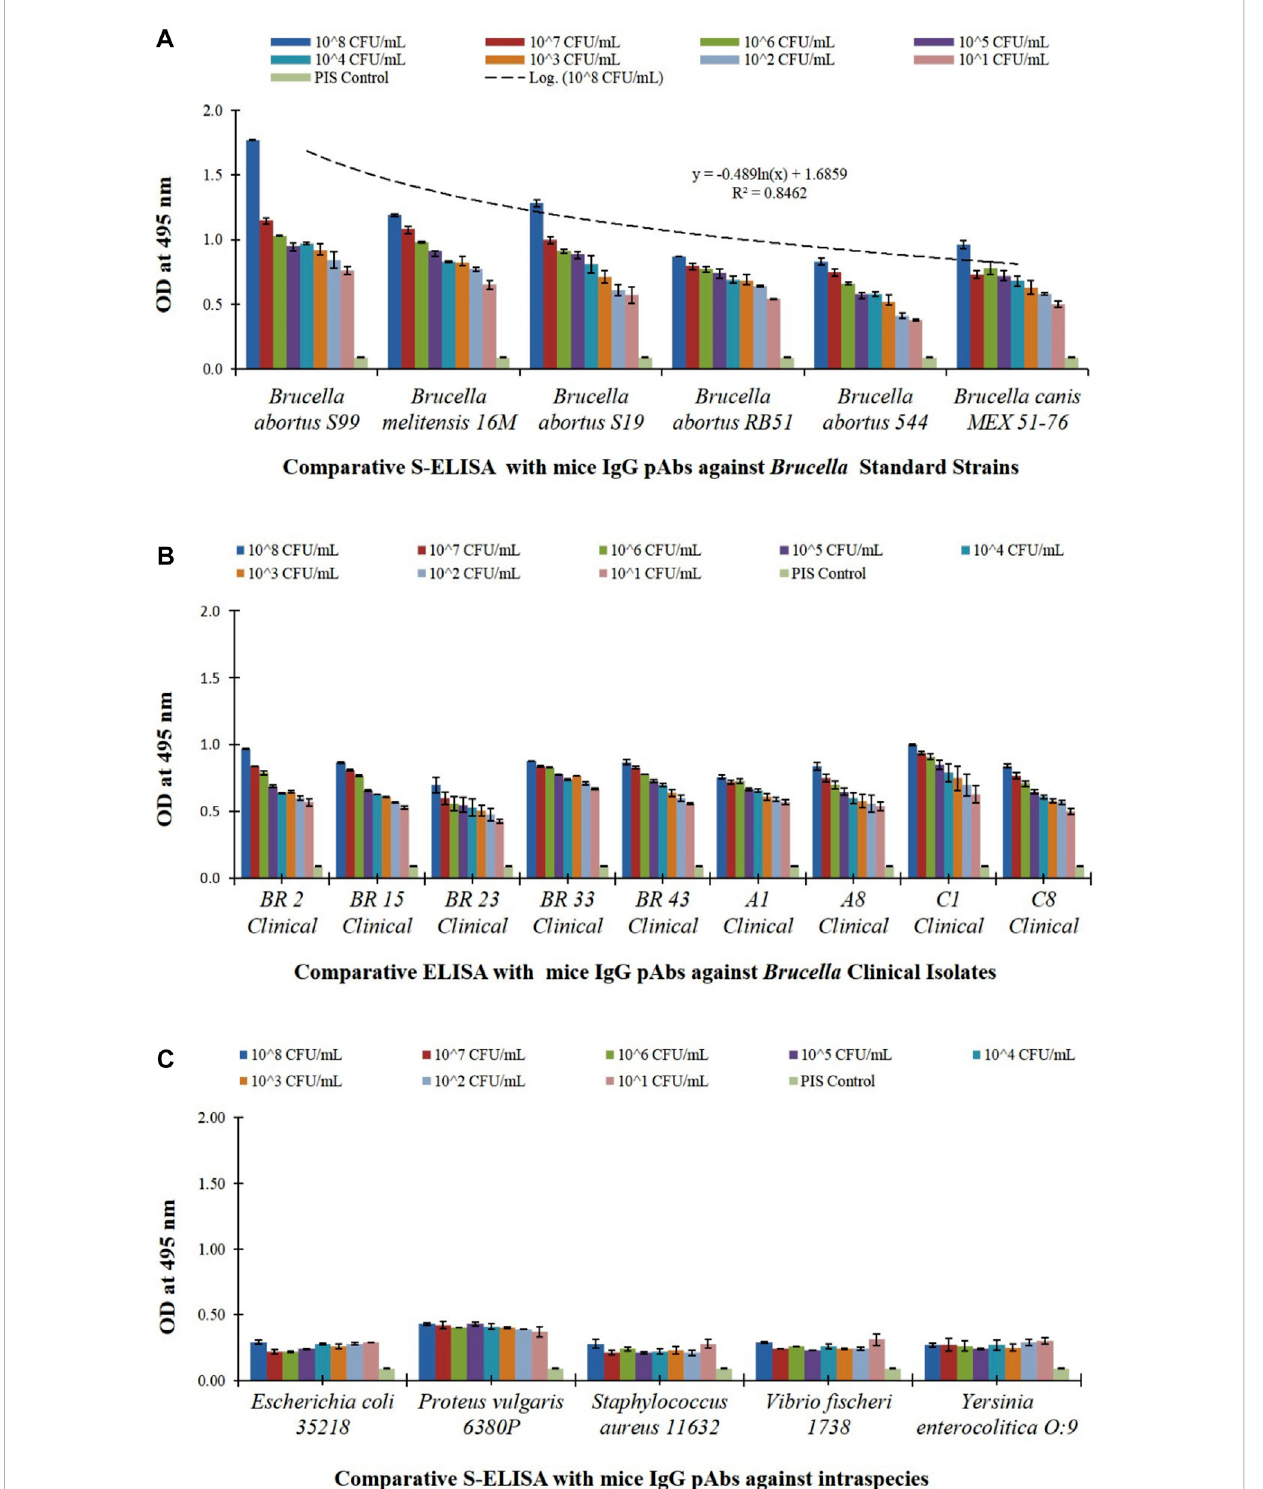
FIGURE 14 Comparative S-ELISA assay for Brucella intact WC detection and for evaluation of cross-reactivity with optimized bioconjugated test antibody (rOmp28 mice polyclonal IgG detection antibody) used in the direct-differential slide agglutination assay, with (A) S-ELISA graph plot showing WC detection of 10-fold serial diluted WC Ag of Brucella standard species at an LOD of 10 3 CFU mL − 1 with a detection range of 10 2 – 10 8 CFU mL − 1 along the x-axis and absorbance at 495 nm along the y-axis. An experimental logarithmic regression coef fi cient value of R 2 = 0.8462 was obtained with the variable model equation of y = ‒ 0.489ln(x) + 1.6859, showing linearity in the trend of Brucella WC Ag detection, (B) S-ELISA graph plot showing WC detection of 10-fold serial diluted, randomly screened WC Ag of Brucella human clinical isolates at an LOD of 10 3 CFU mL − 1 with a detection range